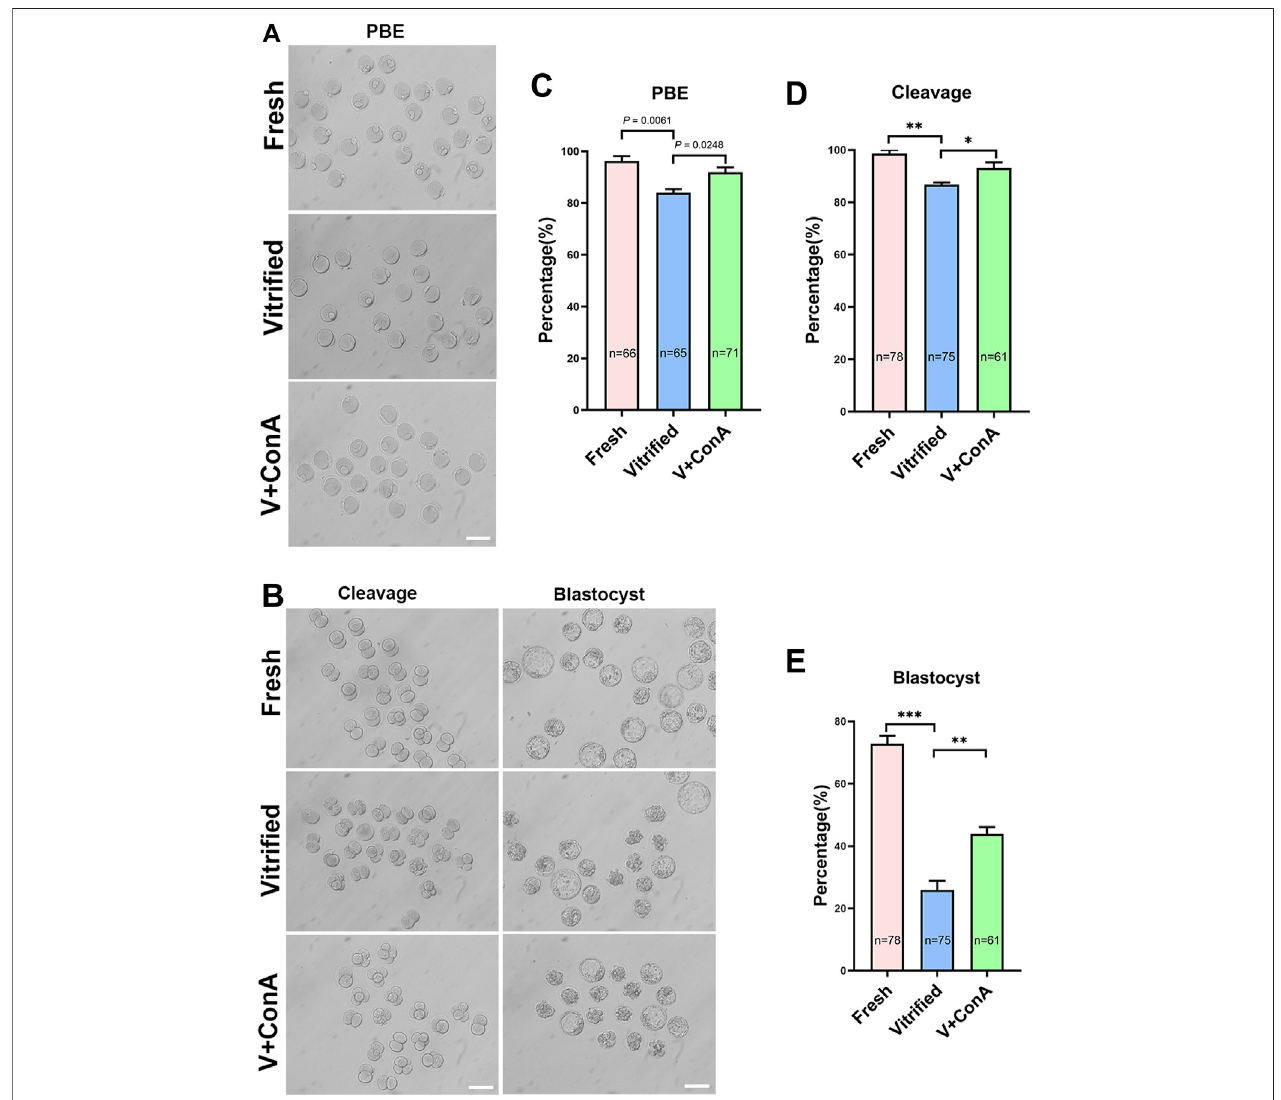
FIGURE 5 | Increasing cortical tension improved the developmental capability of vitri fi ed oocyte. (A) Representative images of polar body extrusion in the fresh, vitri fi ed, and V + ConA groups. Scale bar = 50 μ m. (B) Representative images of embryos development in the fresh, vitri fi ed, and V + ConA groups. Scale bar = 50 μ m. (C) Therateofpolarbodyextrusioninthefresh( n =66),vitri fi ed( n =65),andV+ConA( n =71)groups. (D) Therateofcleavageinthefresh( n =78),vitri fi ed( n =75),andV + ConA ( n = 61) groups. (E) The rate of blastocyst in the fresh ( n = 78), vitri fi ed (n = 75), and V + ConA ( n = 61) groups. Data were presented as mean percentage (mean ± SEM) of at least three independent experiments. * p < 0.05, ** p < 0.01, *** p < 0.001.